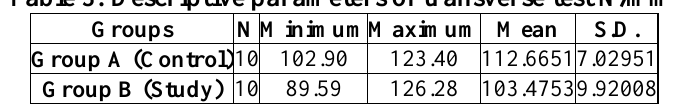
Table 3: Descriptive parameters of transverse test N/mm 2